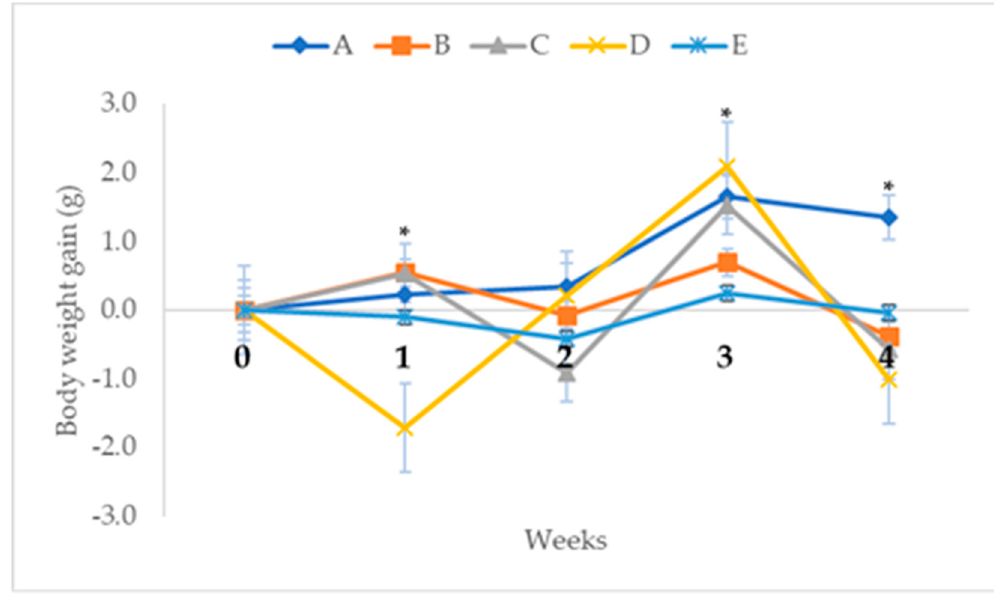
Figure 11. Average (mean ± SEM) weekly body weight gain (g) of female ICR mice in subacute toxicity study of CELE. Key: A = control, B = 125 mg/kg CELE, C = 250 mg/kg CELE, D = 500 mg/kg CELE, E = 1000 mg/kg CELE, * significantly different at p < 0.05, SEM = standard error of mean, CELE = Clinacanthus nutans ethanolic leaf extract.